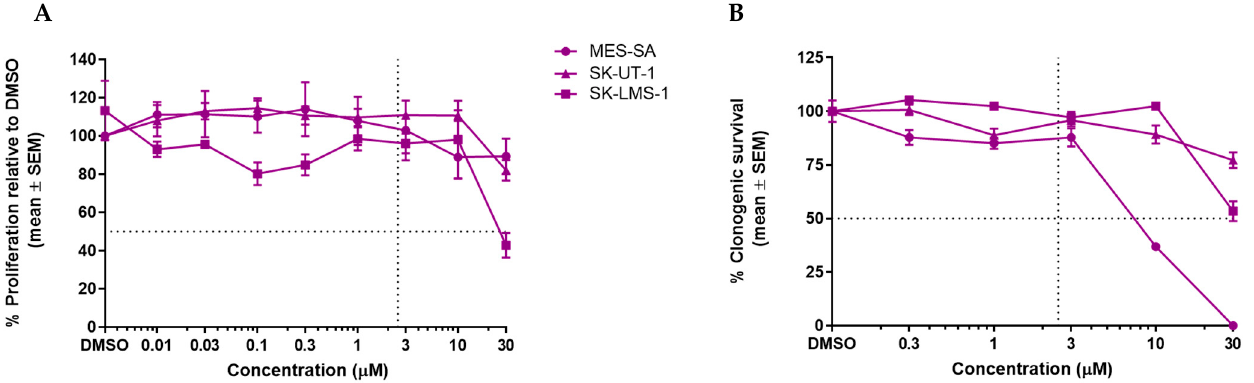
Figure 2. Growth inhibitory and cytotoxic effects of GSK2830371 as a single agent on LMS cell lines. Dashed lines highlight 2.5 µM and 50% proliferation/clonogenic survival. ( A ) Dose-response curves following 72 h incubation with GSK2830371 (SRB assay); ( B ) dose-response curves from clonogenic survival assays used to determine LC 50 concentrations. Cells were treated for 72 h then left to incubate for 14 days. Data points represent the mean ± SEM of three independent repeats.